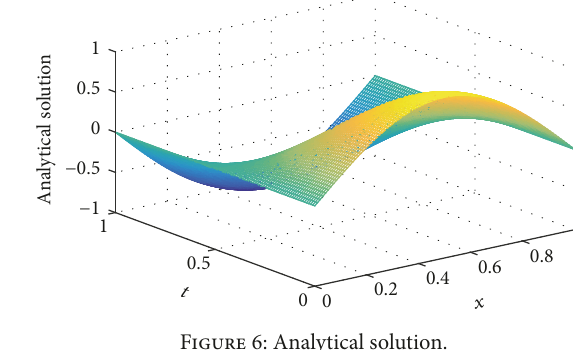
Figure 6: Analytical solution.